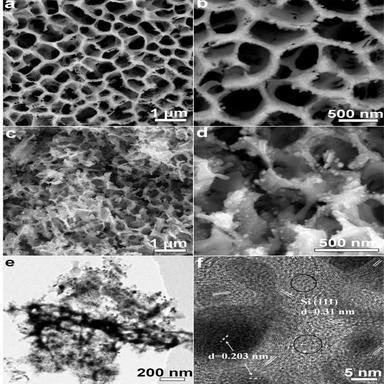
(a, b) SEM images of the dealloyed MP-Si/Ni sample, (c, d) after carbonization, (e, f) TEM images of the MP-Si/Ni/C composite.